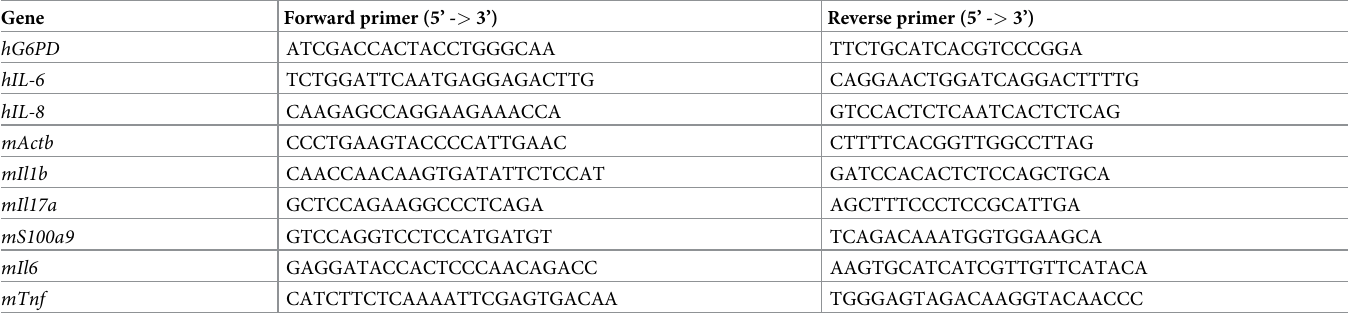
Table 3. Primers for detecting host transcripts.